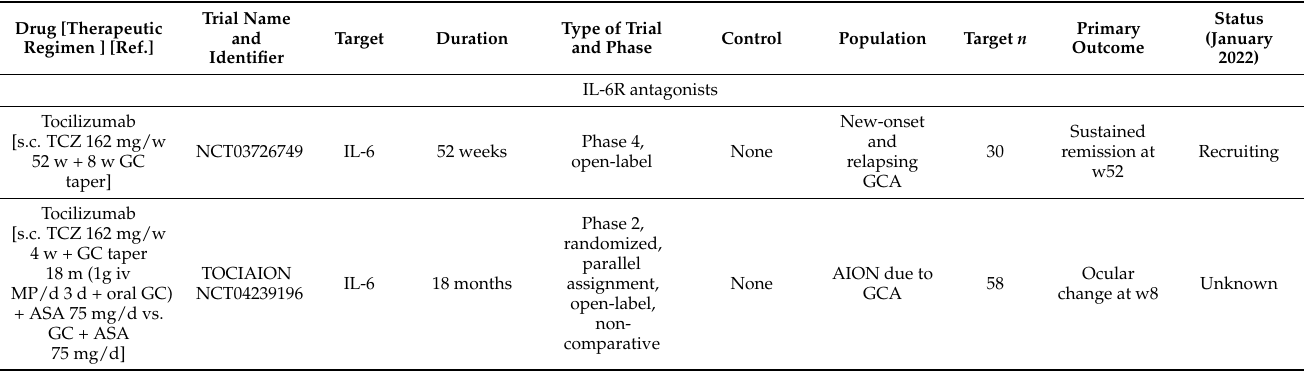
Table 3. Ongoing or yet to publish randomized clinical trials investigating biologic or targeted therapies for giant cell